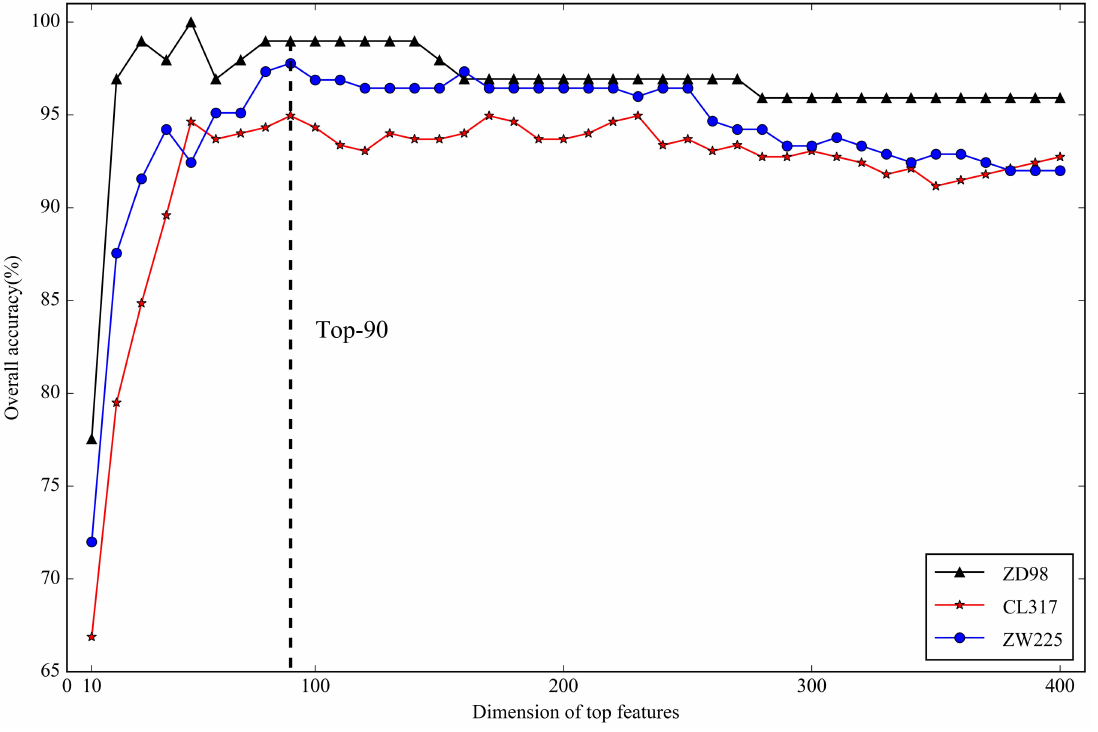
Figure 4. The effect of the Top- K features on overall accuracy based on datasets ZD98, CL317, and